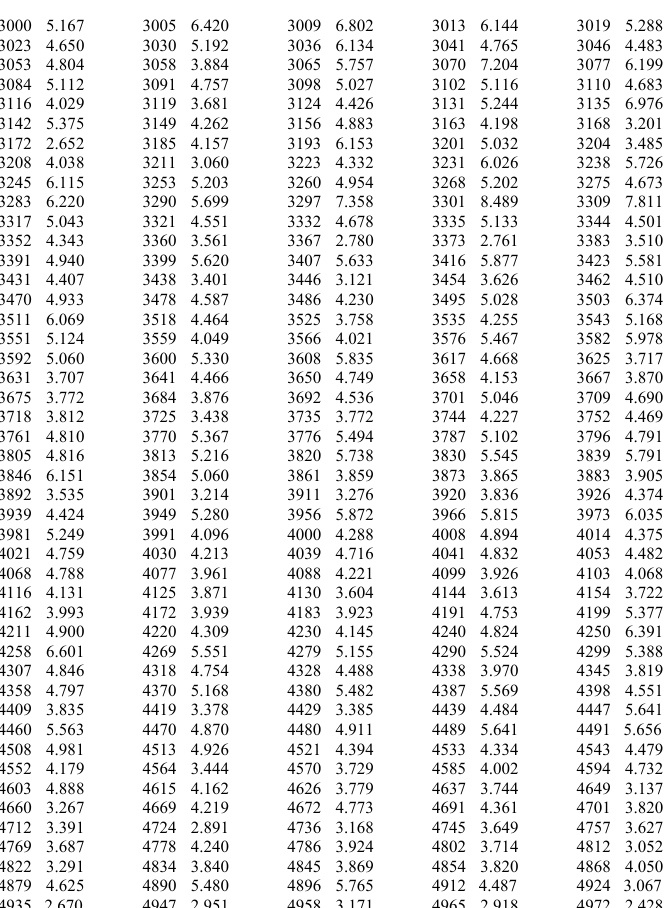
Table 1. USC-Eval [Energy in eV – Cross section in barn] 3000